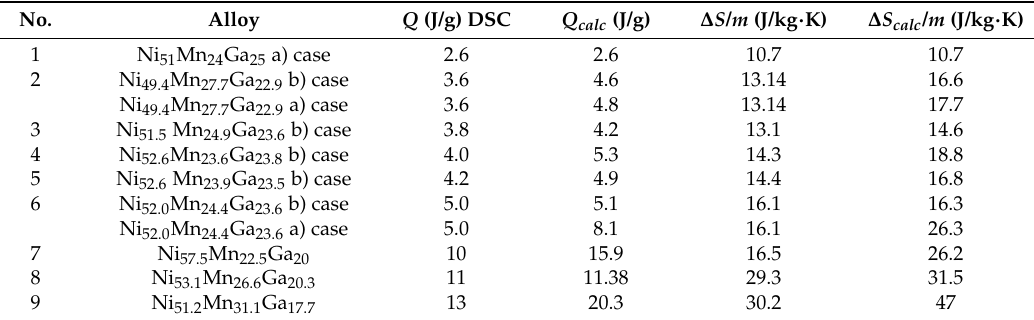
Table 1. DSC-measured transformation heat Q , calculated transformation heat Q calc , estimated entropy change by unit of mass ∆ S / m , and calculated entropy change by unit of mass ∆ S calc / m for different Ni-Mn-Ga alloys. The a) and b) cases denote the axis direction along which the compression force was applied, as explained in the